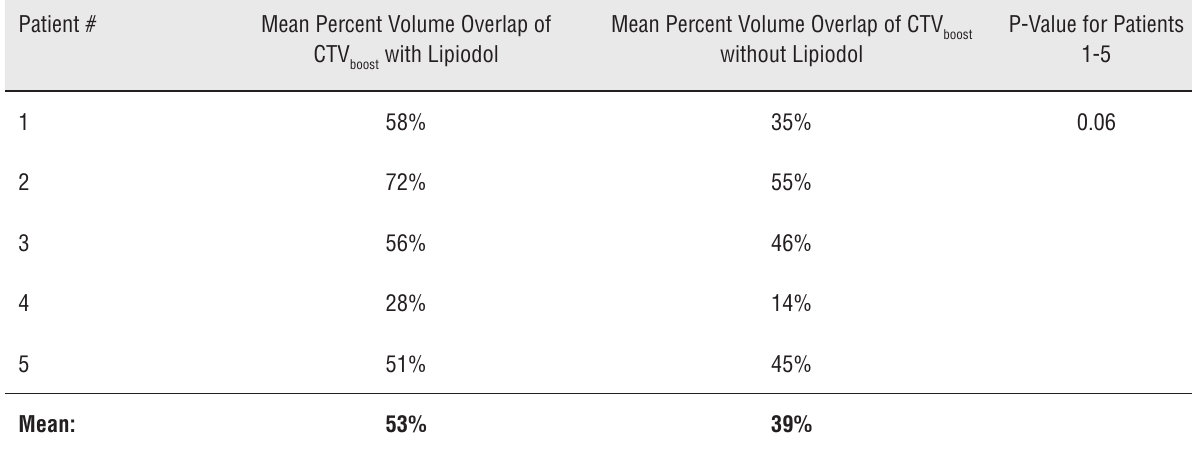
with versus without Lipiodol. boost